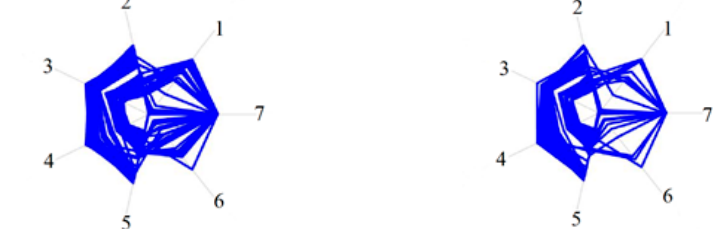
Figure 1. Indicators data radar chart.